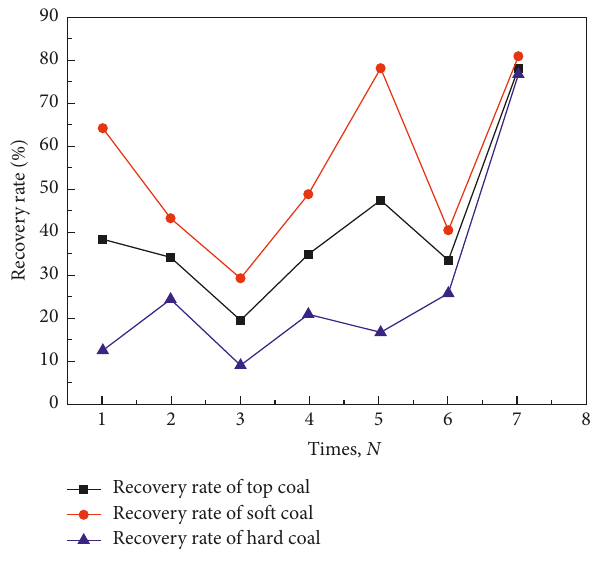
Figure 15: Top coal recovery